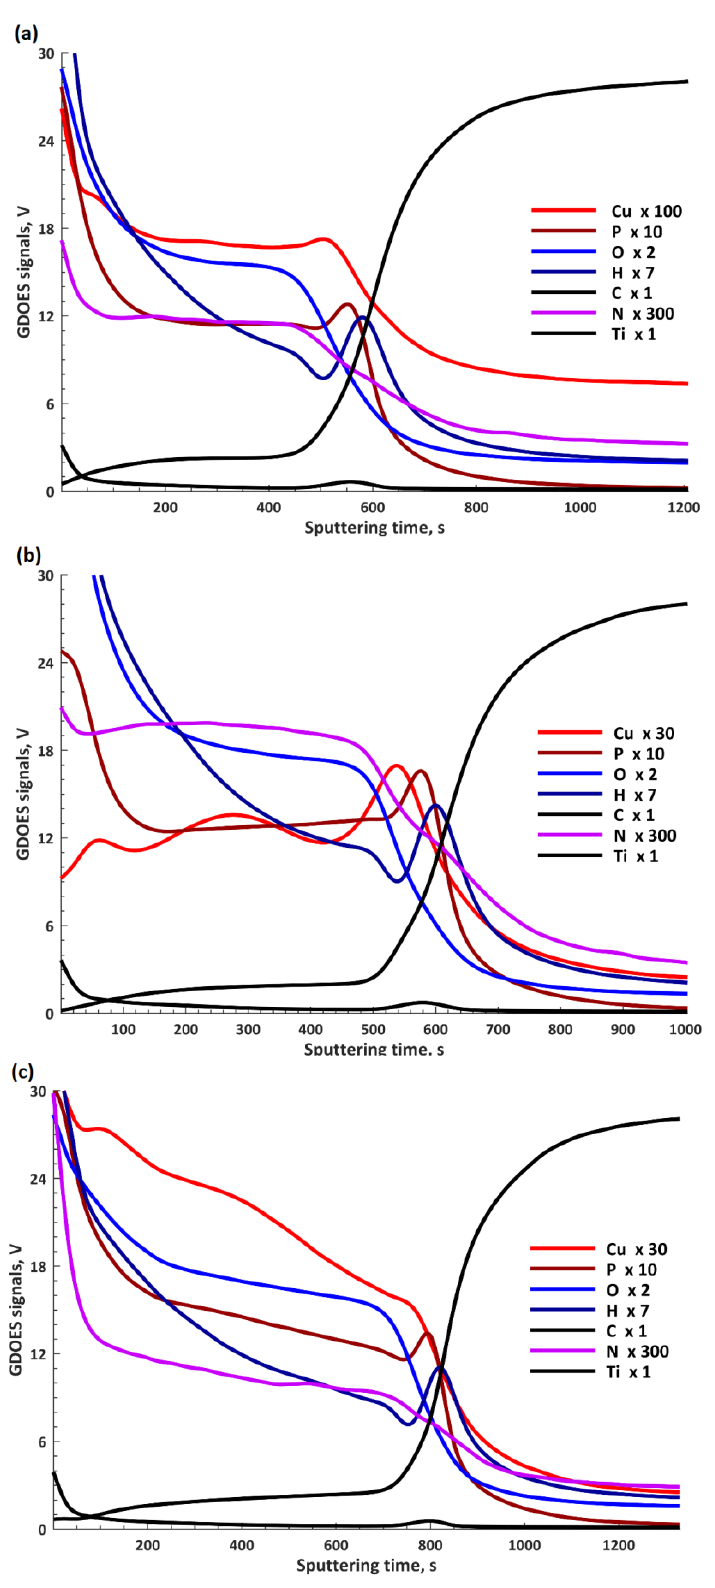
Figure 7. The GDOES depth profiles of the three coatings: TiCu300 ( a ), TiCu450 ( b ), and TiCu600 ( c ).